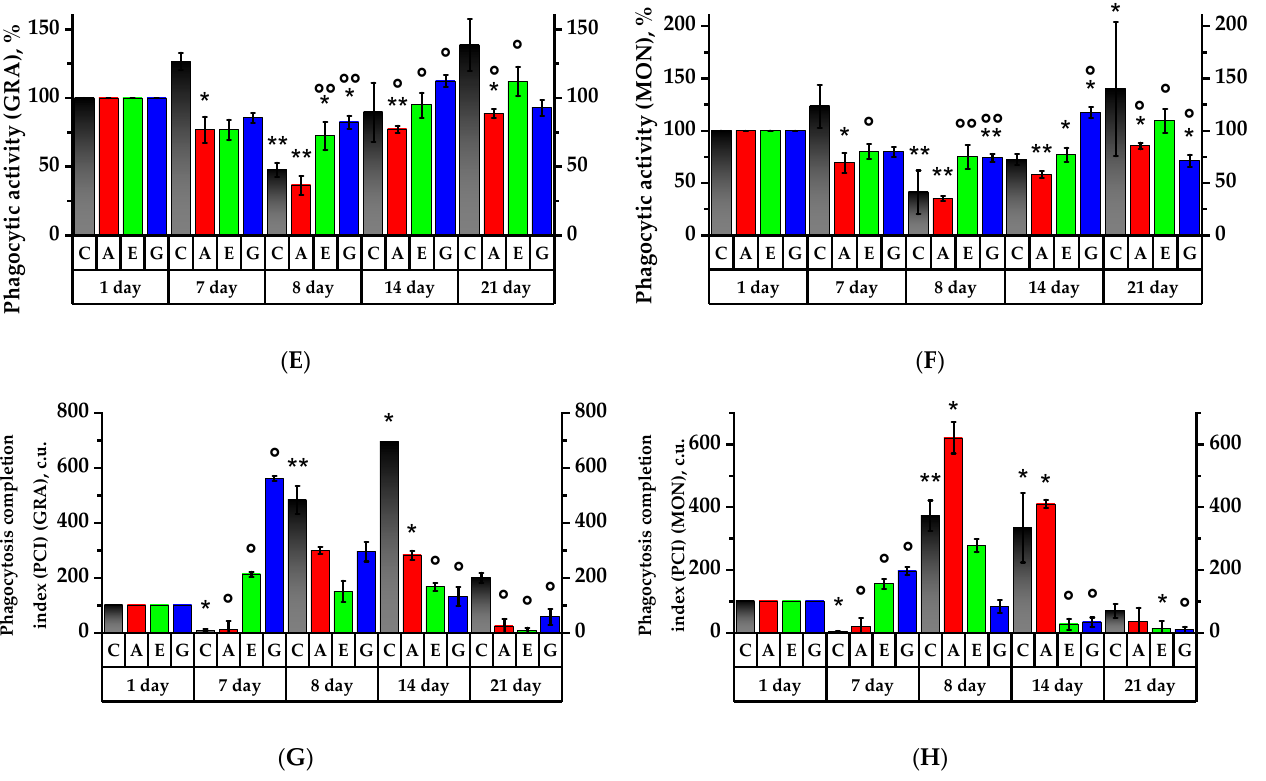
Figure 6. Phagocytic activity of neutrophil granulocytes and rat peripheral blood monocytes. Val- ues (phagocytic index ( A , B ), phagocyte number ( C , D )) are expressed in conventional units (c.u.); phagocytic activity ( E , F ) is expressed in %; phagocytosis completion index ( G , H )) is expressed in c.u. * p < 0.05, ** p < 0.01, significance of differences compared to the 1st day of the experiment; ° p < 0.05, °° p < 0.01, significance of differences between the animal groups as compared to the Control Group.